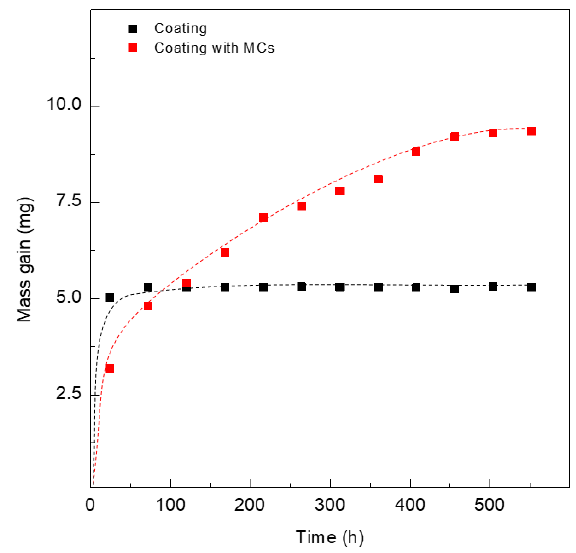
Figure 5. The water uptake of Valspar Greenbar coating with microcapsules (MCs) and without microcapsules (blank) on carbon steel plates measured by mass change.